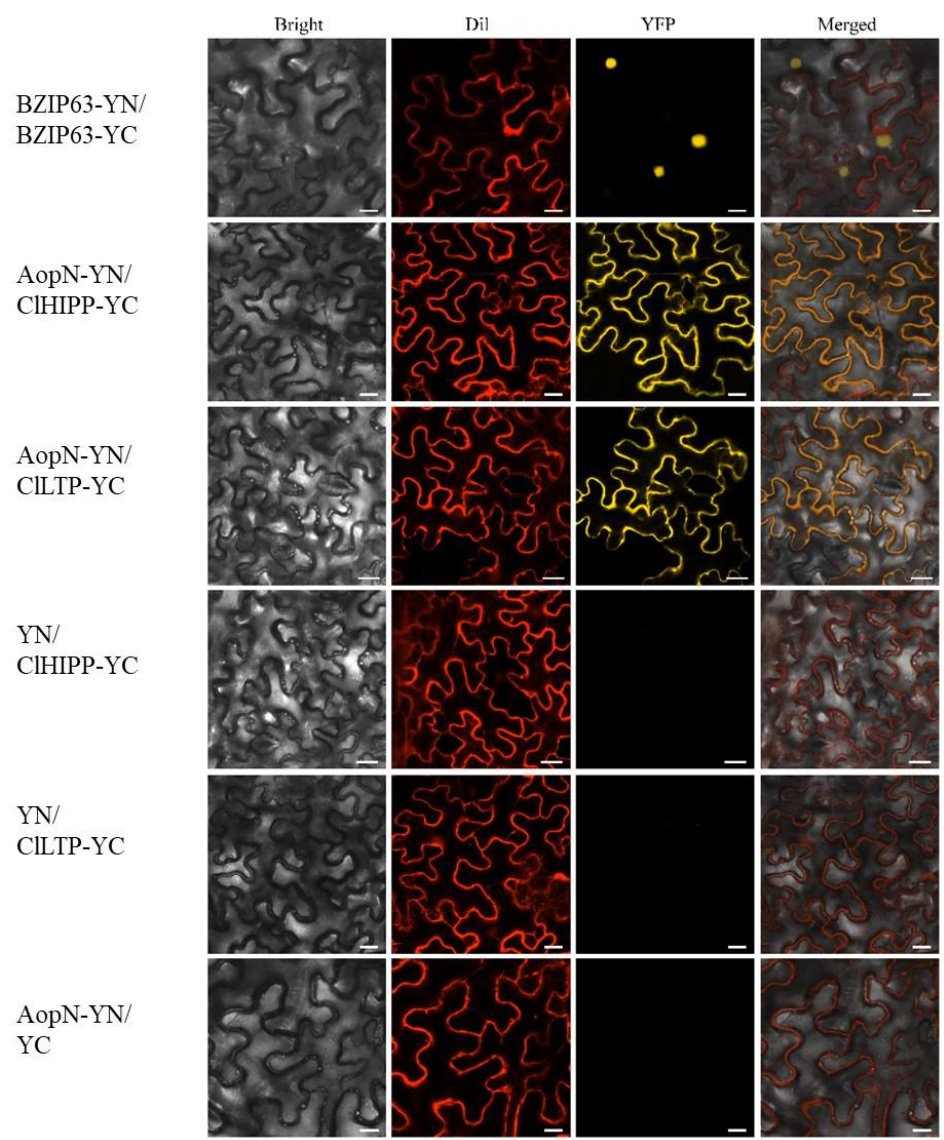
Figure 8. The bimolecular fluorescence complementation (BiFC) verified the interaction between AopN and ClHIPP, as well as AopN and ClLTP. AopN was fused with the nYFP tag, and ClHIPP and ClLTP were fused with the cYFP tag. Fluorescent dye (D3911, Thermo) was used as a control for plasma membrane localization. The experiment was performed three times, with similar results obtained each time. The white short line in the lower right corner of the figure represents the scale bar (25 µm).